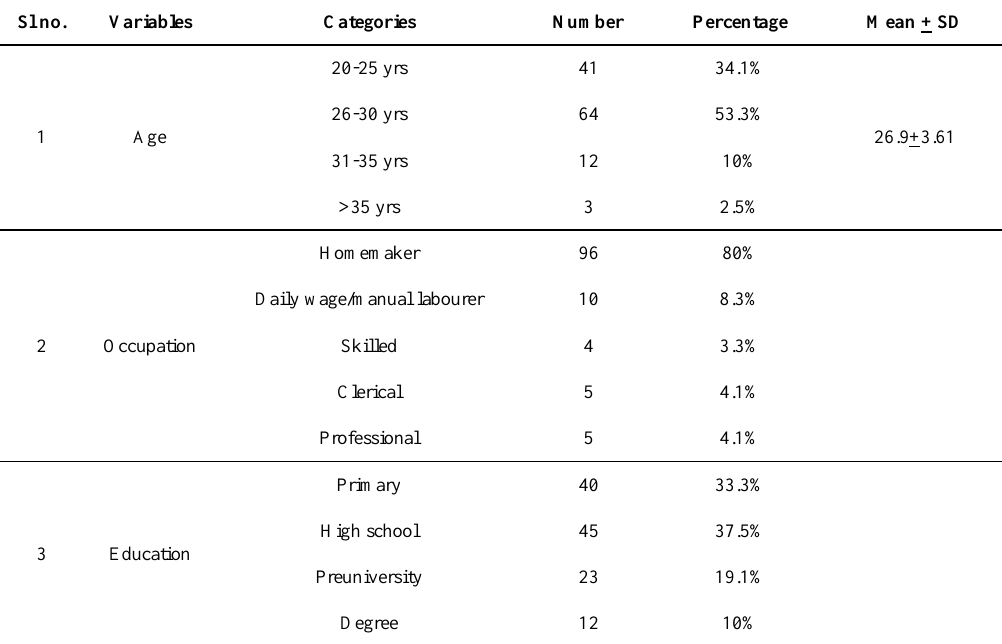
Table 1. Demographic